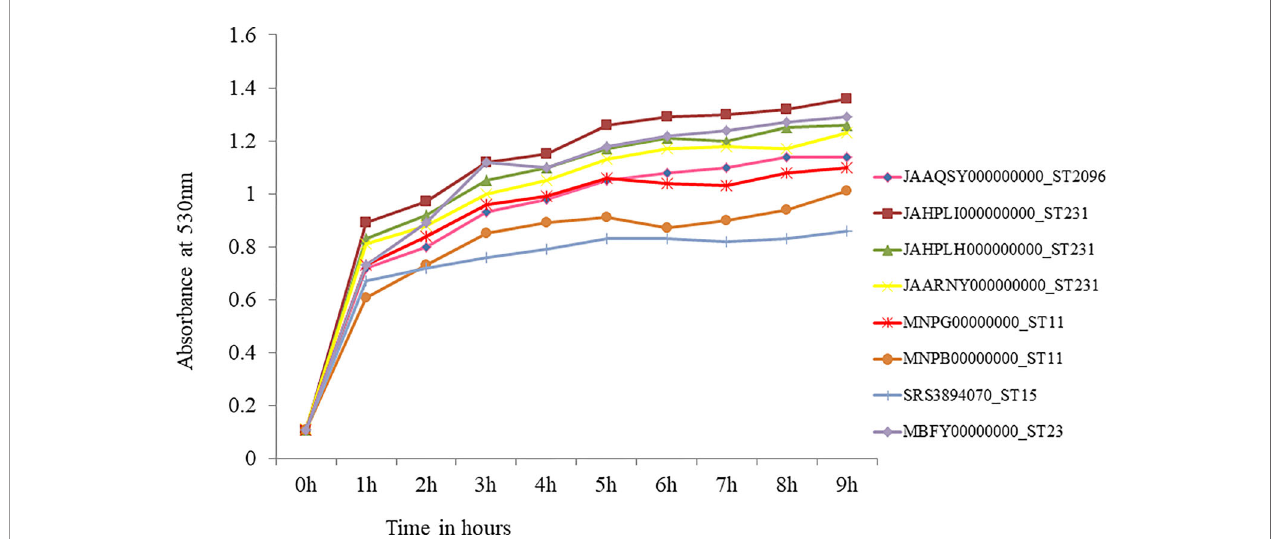
FIGURE 7 | In-vitro growth curve of hypervirulent Klebsiella pneumoniae. Isolate belonging to ST23 (MBFY00000000) was pan-susceptible and carries wild type rmpA and rmpA2 . Isolates belonging to ST231 (JAHPLI000000000, JAHPLH000000000, JAARNY000000000) that carried aerobactin alone showed similar growth when compared to ST23. CRKp belonging to high risk clones ST11 ( rmpA2 _2, MNPG00000000; rmpA2 _2, MNPB00000000) and ST15 ( rmpA2 _9; SRS3894070) showed slower growth than ST23 and ST231